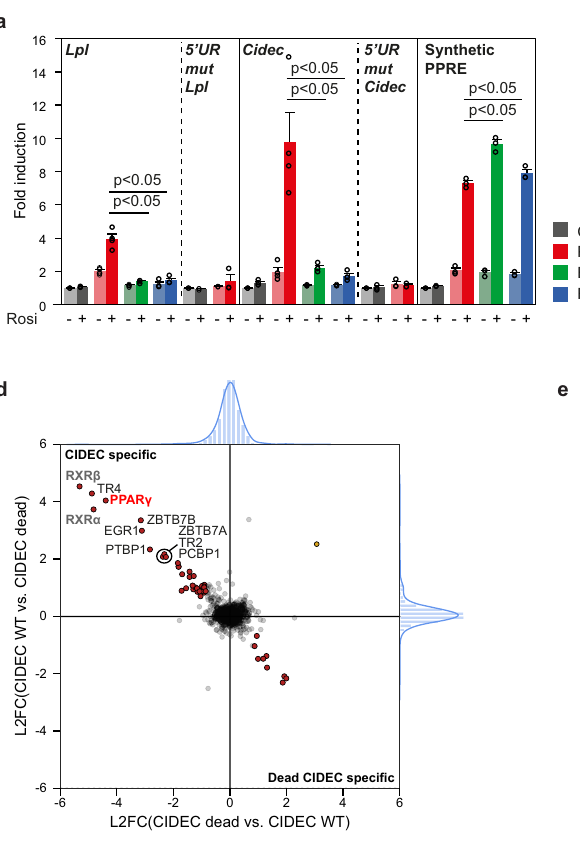
Fig. 2 | E379K and R212Q mutants destabilize PPAR γ :RXR binding to DNA in vitro. a U2OS cells were transiently cotransfected with expression vectors encoding PPAR γ -WT or mutants and different reporter constructs as indicated, in the absence or presence of 1 µ M rosiglitazone. Activation of the reporter is expressed as fold induction over that with empty vector (control). Data are pre- sented as mean values+SEM, with individual data points indicated with circles, n =3 – 4 biologically independent experiments. One-way ANOVA with Tukey ’ s multiple comparisons were used to compare cells transfected with mutant vs. WT; * p <0.05 cellstransfected with mutant vs. WT. b Expressionofthe different PPAR γ proteins transiently overexpressed in U2OS cells, as assessed by western blot. The arrow indicates PPAR γ , and the asterisk indicates a non-speci fi c band. Control, empty vector control; WT, PPAR γ wild-type. Three independent experiments were performed and similar results were obtained. c Expression of the different FLAG- tagged PPAR γ proteins stably overexpressed in U2OS cells, as assessed by western blot using a FLAG-tag antibody. Control, empty vector control; WT, wild-type.